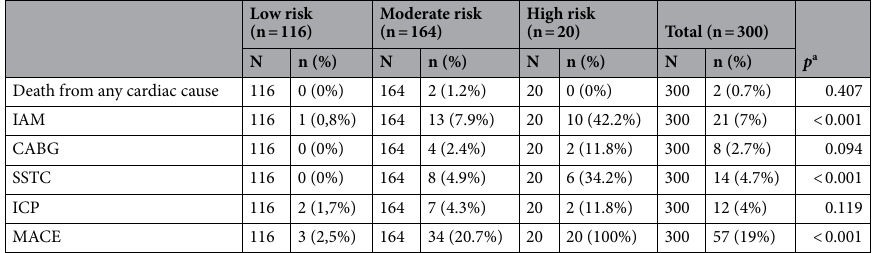
Table 3. MACE according to the stratification made by HEART scale. MACE Major adverse cardiovascular events, MI Myocardial infarction, CR Coronary revascularization, SSCT Significant stenosis with conservative treatment, p p -value. a Chi-square test.